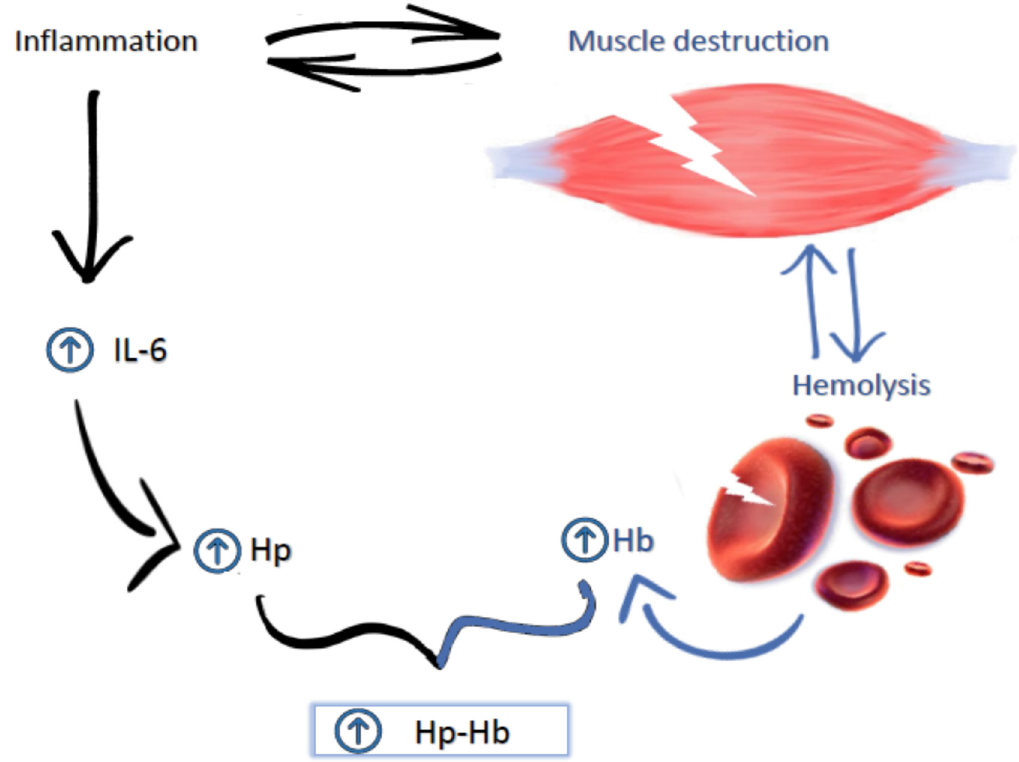
Figure 1. Multiple sclerosis (MS) courses with high inflammation levels characterized by an interleukin 6 (IL-6) increase, on which the expression of haptoglobin (Hp) depends, in turn. In addition to being linked to inflammation, this disease courses with muscular destruction, which is, in turn, related to hemolysis; this hemolysis increases muscular destruction, as a consequence of the free hemoglobin (Hb) pro-oxidative action. On the other hand, a plasmatic Hp increase promotes its union to free Hb (Hp–Hb), decreasing its blood levels and limiting, therefore, its pro-oxidative action.